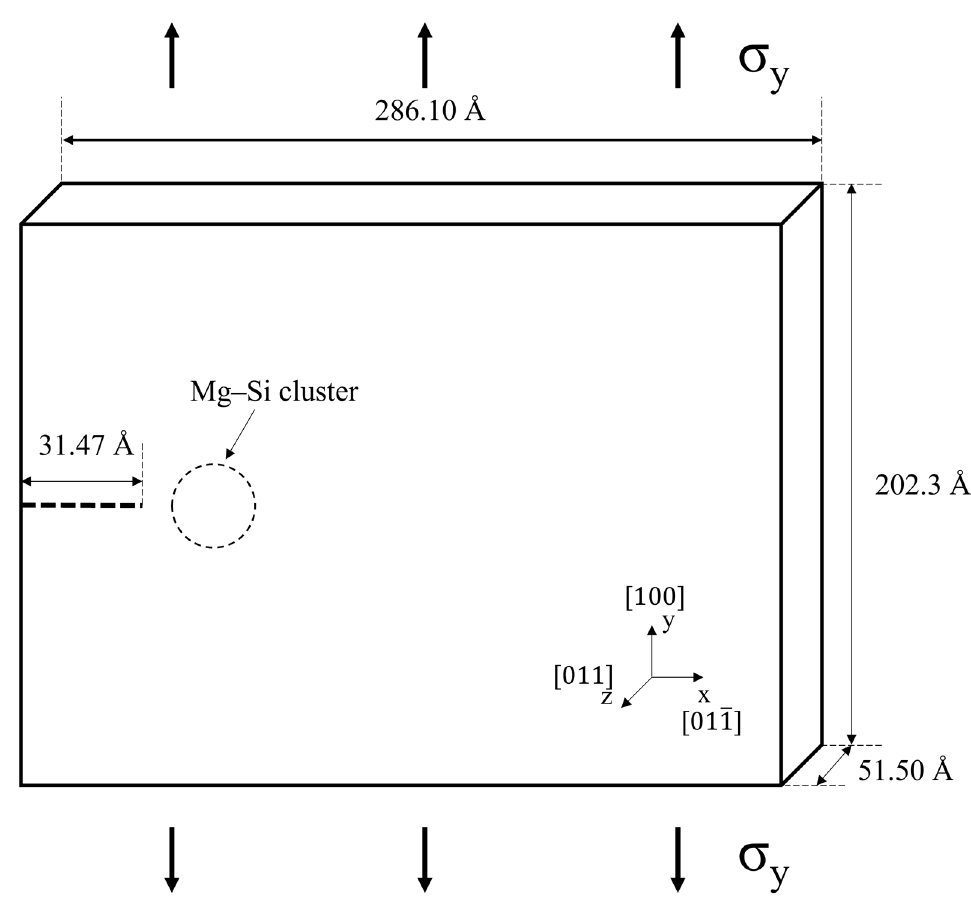
Figure 1. Schematic representation of the MD simulation modeling.